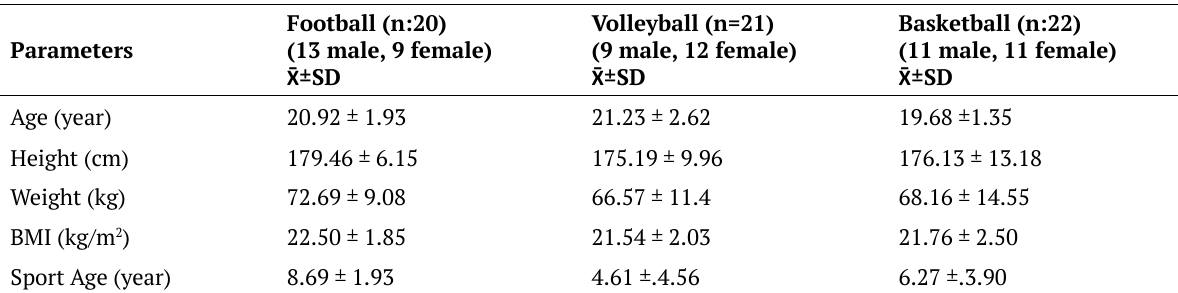
Table 1. Descriptive Information of Participants